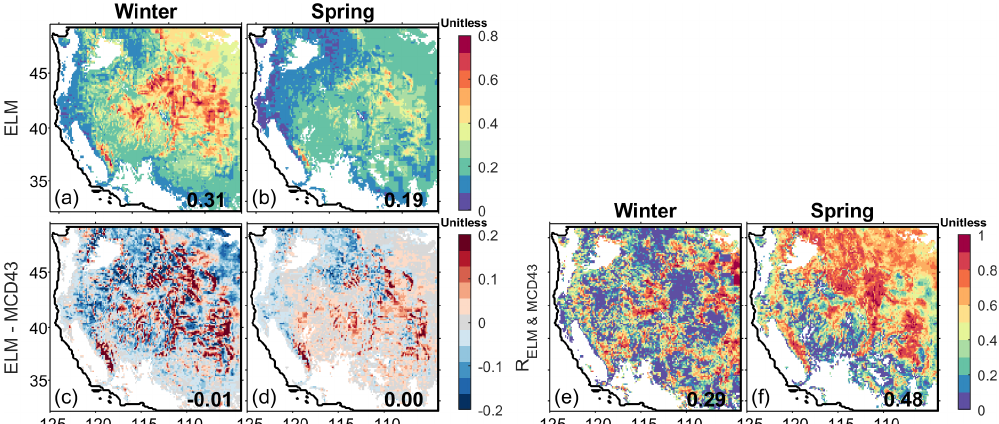
Figure 6. Spatial distributions of (a, b) surface albedo ( α sur ) in ELM, and (c, d) the α sur difference between ELM and MCD43 and (e, f) their temporal correlations ( R s ) for different seasons: (a, c, e) winter and (b, d, f) spring. In all panels, the regions with no snow cover are masked with white color. The area-weighted average values are labeled in each